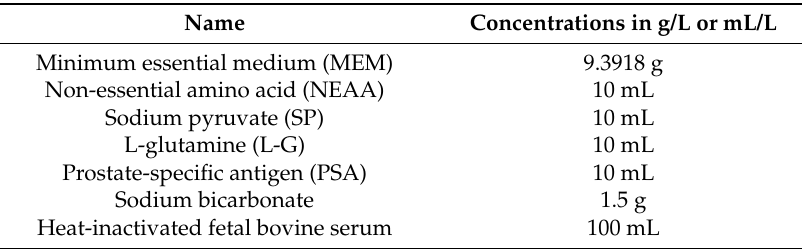
Table 2. Components of MG-63 cell culture